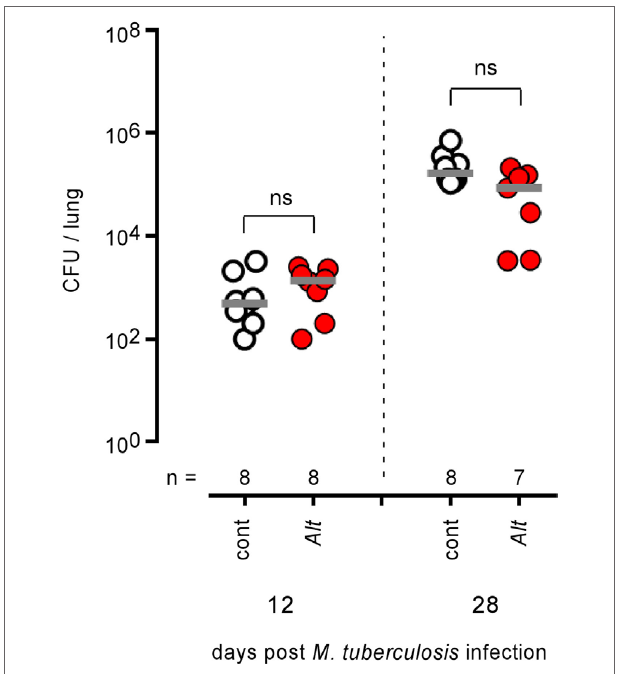
FigUre 12 | Asthma sensitization does not affect the course of Mycobacterium tuberculosis infection in the lungs of mice. Wild-type BALB/c mice were sensitized with phosphate-buffered saline (cont) or Alt before aerosol infection with 10 2 CFU of M. tuberculosis . Mice were sacrificed at the indicated time post M. tuberculosis infection. The data show the CFU/lung. n indicates the number of mice per group. These results are representative of at least two independent experiments.